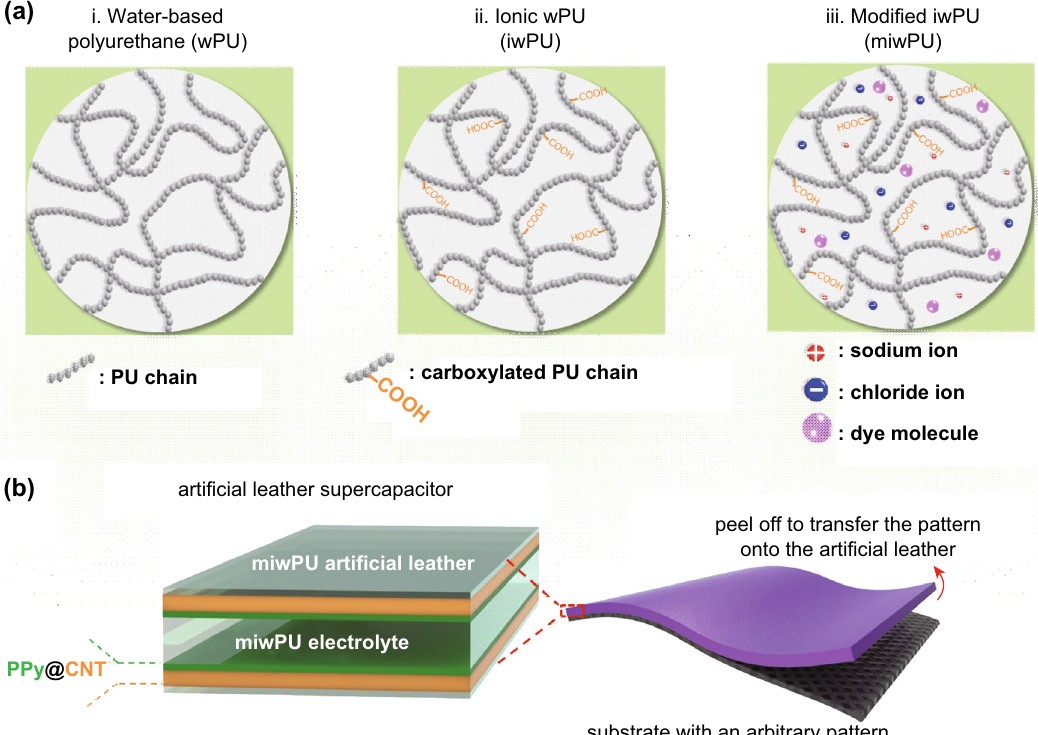
Fig. 1 Schematics of PU artificial leather modification to serve as a polyelectrolyte of an artificial leather supercapacitor. a From wPU to miwPU: (i) wPU without free ions, (ii) iwPU with ionic groups grafted on polymer chains, (iii) miwPU with the presence of NaCl and dyes. b The artificial leather supercapacitor comprising the miwPU electrolyte, PPy@CNT sheet electrodes, and miwPU artificial leather with patterns transferred from an arbitrary